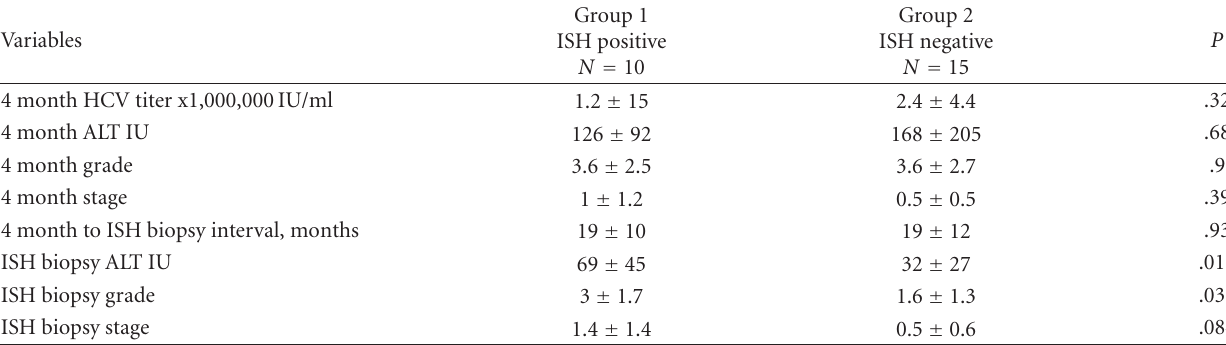
Table 4: HCV viral loads, ALT, and modified Ishak score grade and stage for groups 1 and 2, at 4 months post LT and at the ISH biopsy.